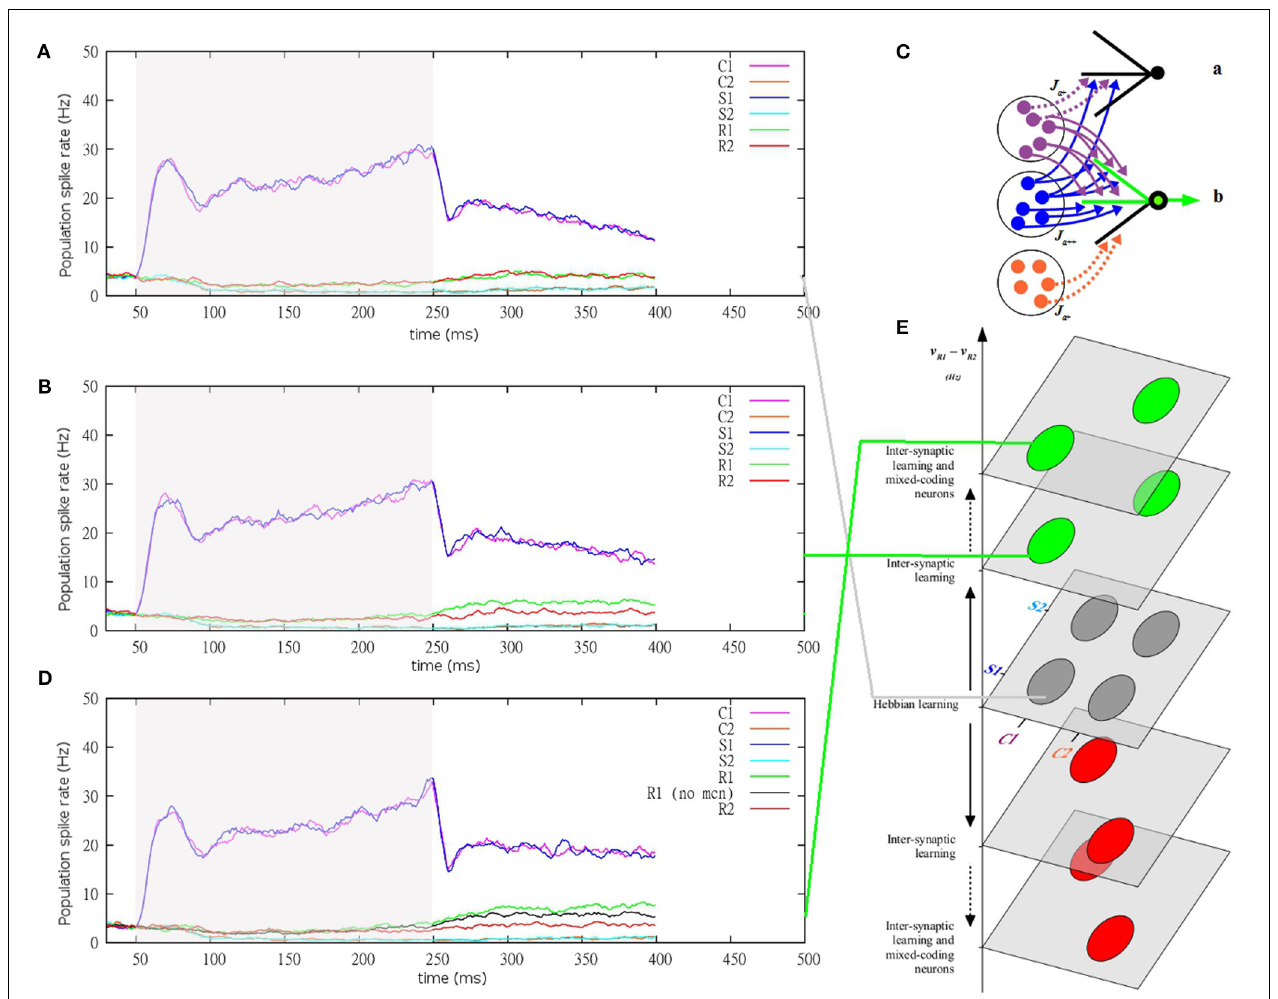
FIGURE 4 | Attractor states and behavior of the cortical network model selecting a response according to a learned combination C1S1R1 and to the following protocol: neurons at spontaneous activity in absence of selective input for 50ms; presentation of Context 1 and Stimulus 1 for 200ms and delay period in absence of selective input for 150ms). (A–C) Average spike rate of populations of neurons (averaged over ten trials) coding for the contexts, stimuli and responses (same color as in Figure 1 ). (A) Case of classic Hebbian learning: neurons coding for R1 and neurons coding for R2 both exhibit prospective activity and are not discriminated. (B) Case of inter-synaptic learning: neurons coding for R1 exhibit higher prospective activity than neurons coding for R2. (C) Example of connectivity to two post-synaptic excitatory neurons that are not selective to any single stimulus or response (NSI-coding neurons) and that do not respond ( a ) or respond ( b ) to combinations of context and stimulus: a , receiving only two synaptic inputs from neurons coding for C1 (purple) and S1 (blue) within one of its dendrites (black line), is not activated when the C1S1 combination is presented; b , receiving three synaptic inputs from each group of neurons (C1 and S1), each within two dendrites (green lines), is activated when the C1S1 combination is presented. During